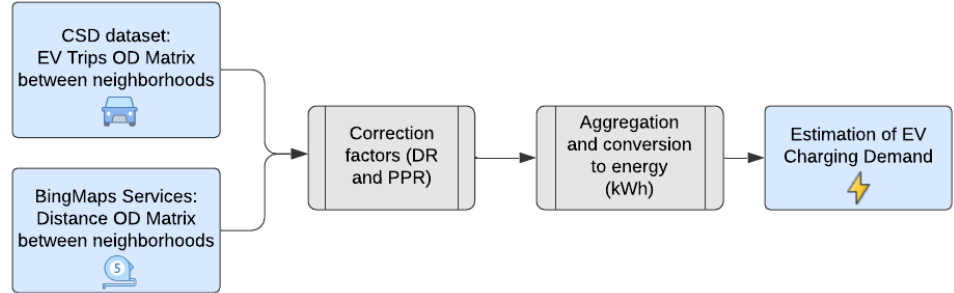
Figure 1. Process of EV charging demand estimation for Brussels. Section 3.1.2 estimates the number of trips between districts based on CSD. Then, it builds an OD matrix by computing the quickest driving distance between neighborhoods. Section 3.1.3 applies two correction factors, the DR and PPR. Section 3.1.4 converts OD matrices into neighborhood-level energy demand in kWh.